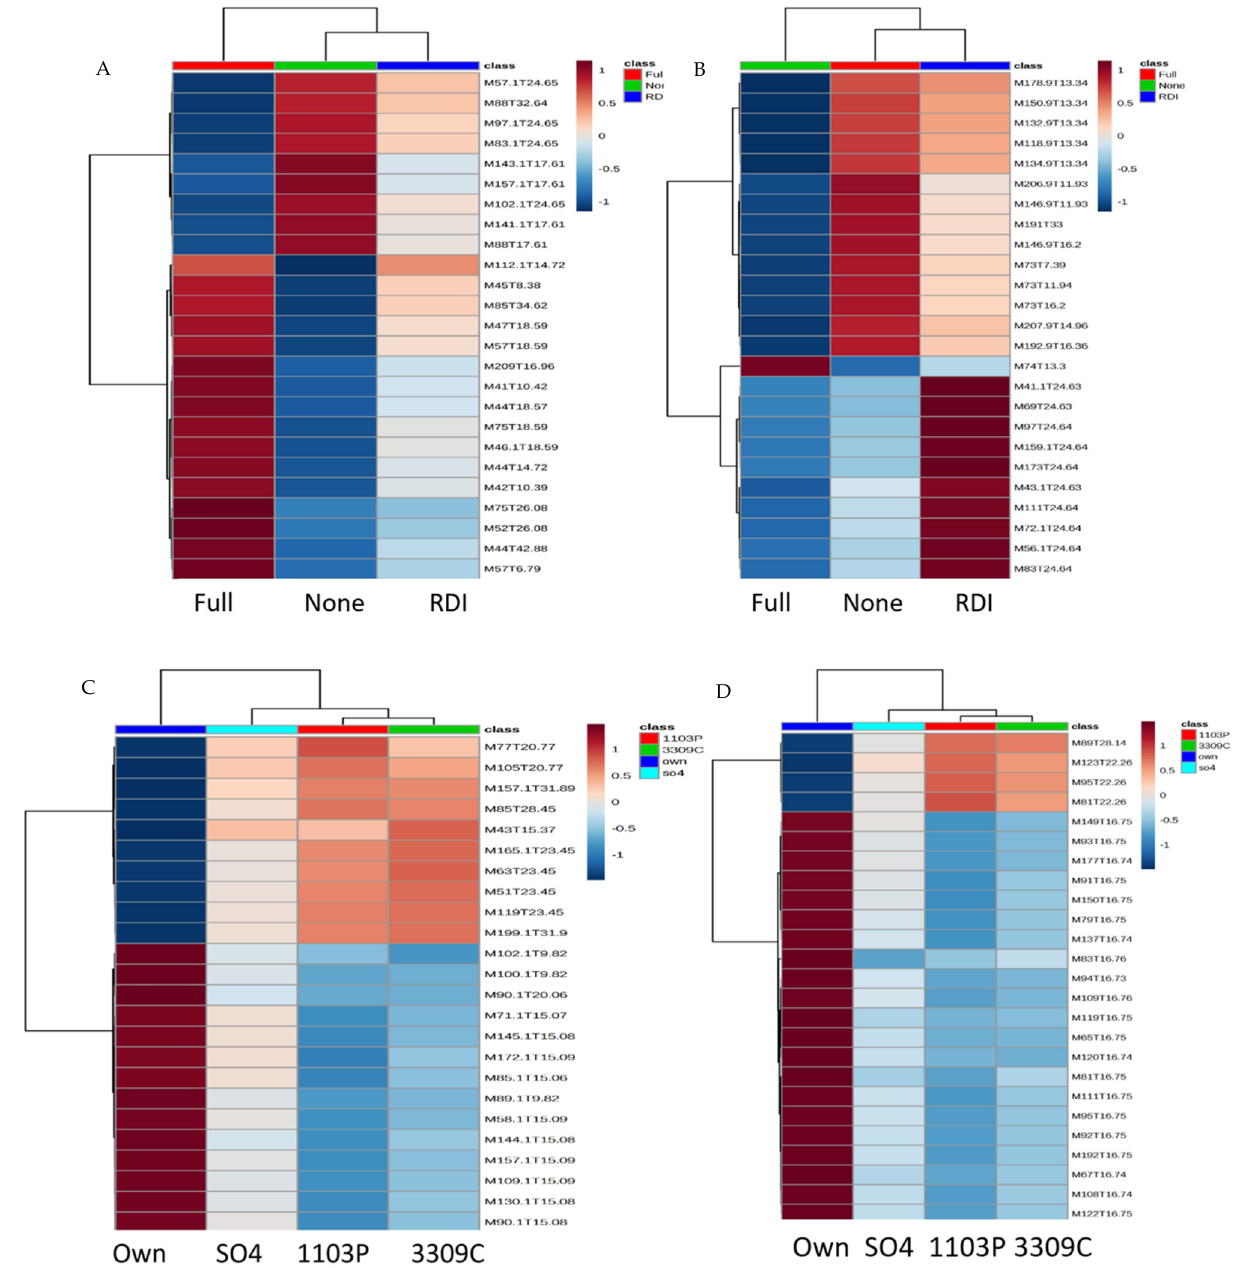
Figure 2. Heatmaps of the top 25 most influential features for differentiating wine volatiles by ( A ) irrigation regime in 2017, ( B ) irrigation regime in 2018, ( C ) root system in 2017, and ( D ) root system in 2018. While only the top contributors are shown, the heatmaps were generated using all features. The rows in the heatmap represent features (M( m/z )). T (time in minutes) and the columns indicate sample categories. The colors of the heatmap cells indicate the abundance of compounds across different samples. The color gradient, ranging from dark blue through white to dark red, represents low, middle, and high abundance of a compound.